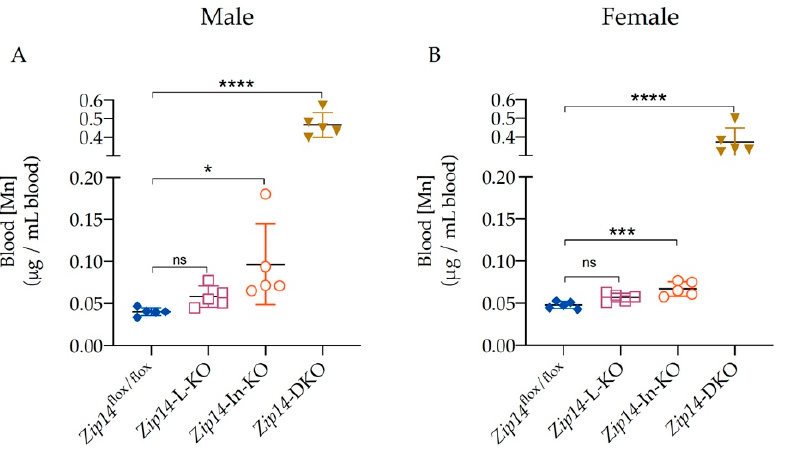
Figure 3. Blood manganese increased significantly in Zip14 -DKO mice. Blood manganese (Mn) concentrations were measured by inductively coupled plasma mass spectrometry (ICP-MS) for ( A ) male mice ( n = 5) and ( B ) female mice ( n = 5) at 9 weeks of age. Data were expressed as mean ± SD and were subjected to a one-way ANOVA followed by the Bonferroni post-hoc test to compare the mean of each knockout group to the control group. * p < 0.05, *** p < 0.001 and **** p < 0.0001. “ns” indicates no significant differences.